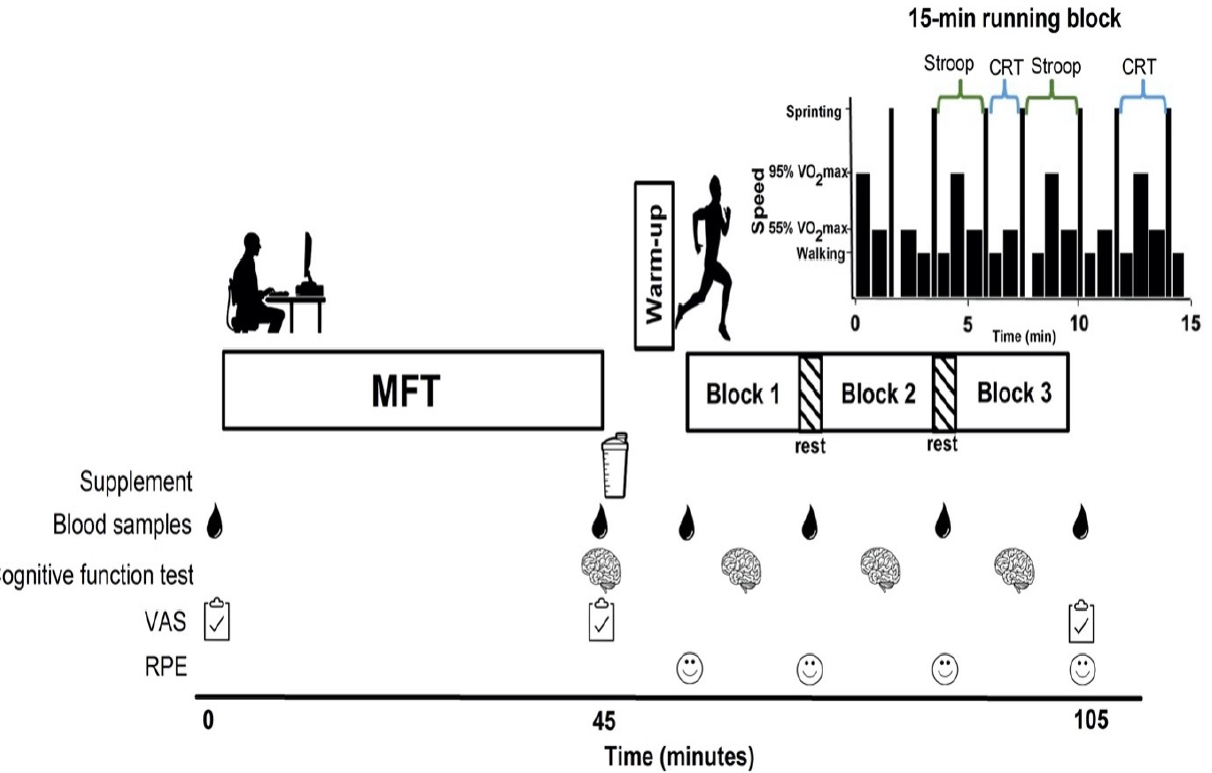
Figure 1. Overview of study protocol. MFT = mental fatiguing task. Cognitive Function Test included the Stroop and Choice Reaction Test.